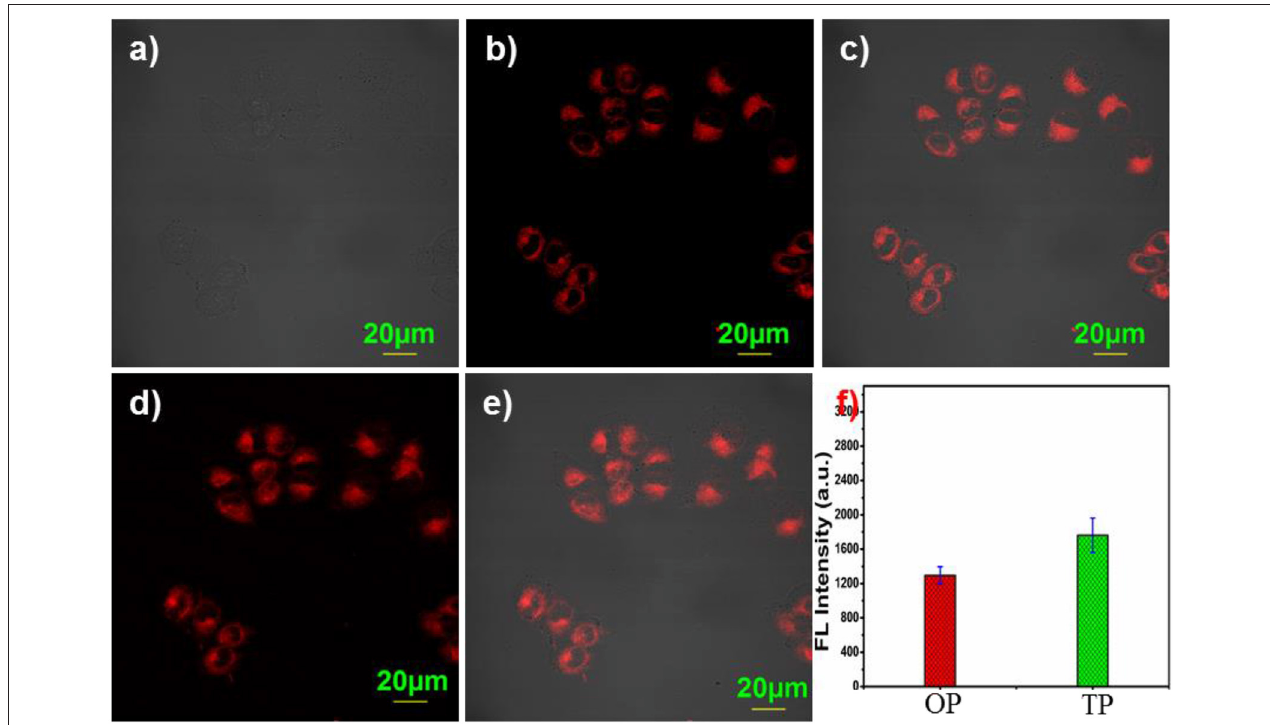
FIGURE 5 | Two-photon fluorescence imaging of probe NIR-SN-GGT in A2780 cells. (a) bright imaging; (b) one-photon imaging; (c) merged imaging from (a,b) ; (d) two-photon imaging; (e) merged imaging between (a) and (d) ; (f) fluorescence emission intensities of NIR channel were measured as averages of 9 regions of interest (ROIs) from different treated A2780 cells. Error bar = RSD ( n = 9). (OP mode) λ ex = 488nm and λ em = 655-755nm; (TP mode) λ ex = 800nm and λ em = 575–630nm. Scale bar = 20 µ m.